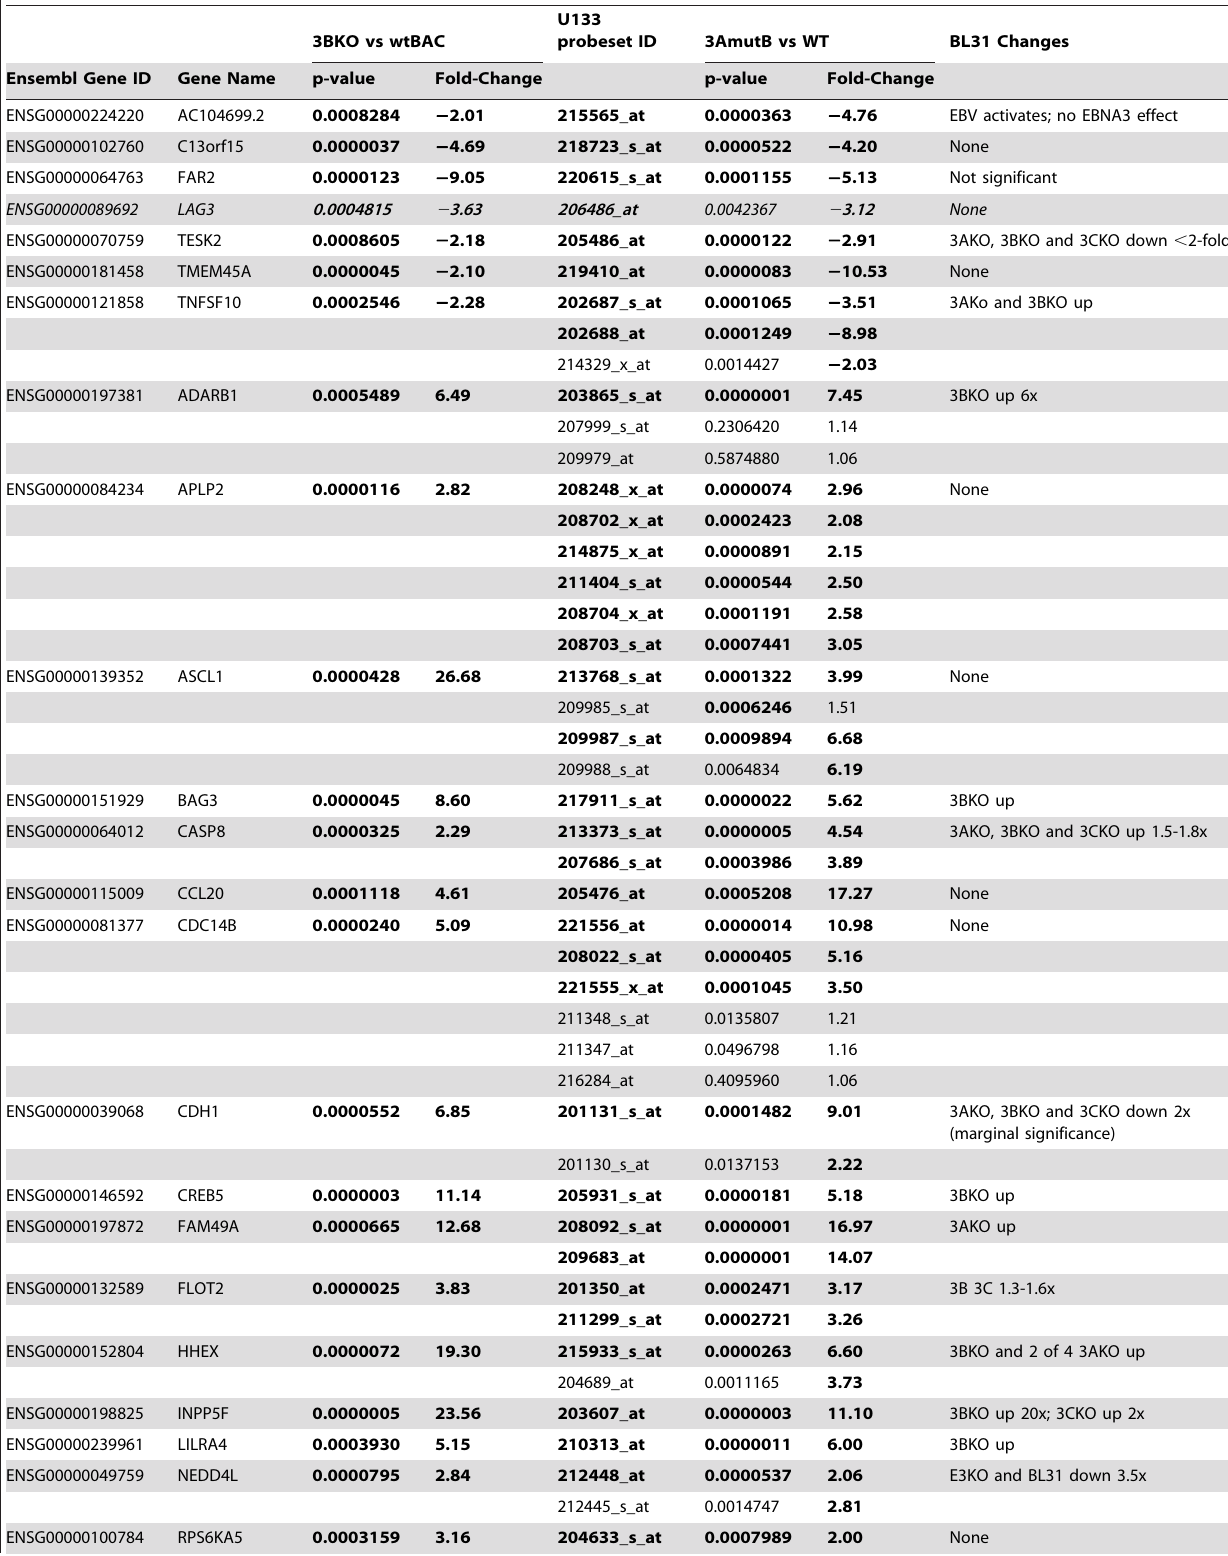
Table 1. Genes whose expression is regulated by EBNA3B and EBNA3A in